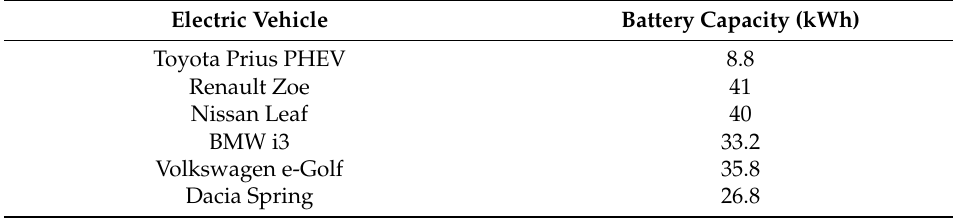
Table 5. Battery capacity of EVs.